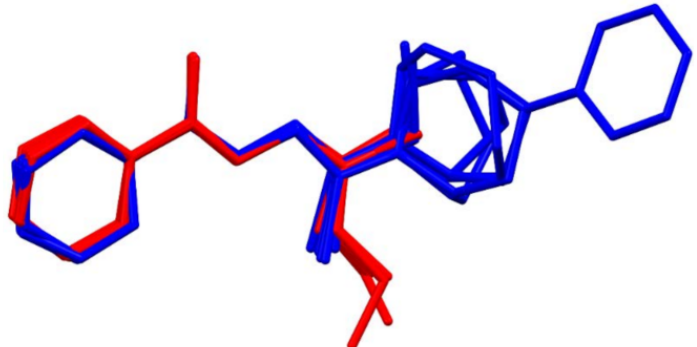
Figure 12. Overlay of molecules for analog structures from CSD (zwitterion form (YACFOY [39], WEX- SUO [11], WEXSOI [11], SUZGUP [40], PASZEP [12], MEVNIK [41], BEWLOH [7], ADABIQ [42])— blue, neutral form (YAPJUV [43], XOTWUY01 [44], WOGGAC [44], WOGFUV [44], UYOSIM [45], MEMWUW [46], DIFROZ01 [47])—red).